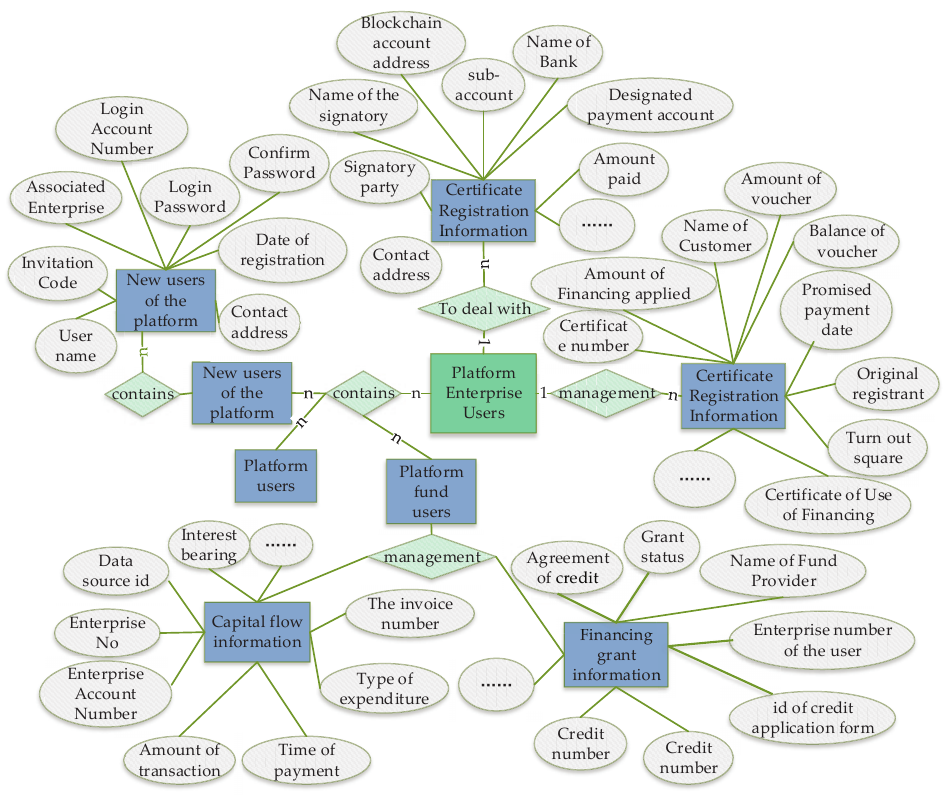
Figure 6. System ER